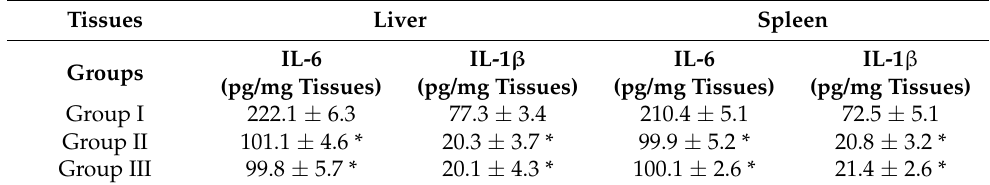
Table 4. Levels of IL-6 and IL-1 β of the liver and spleen tissues of the different groups. Tissues Liver Spleen